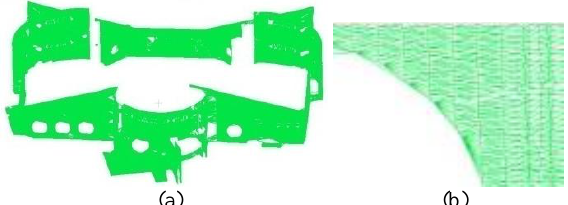
Figure 2. The TLS mesh created after the filtering process (a), detail (b)